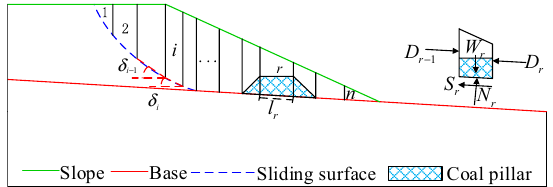
Fig. 9 Slope and supporting coal pillar